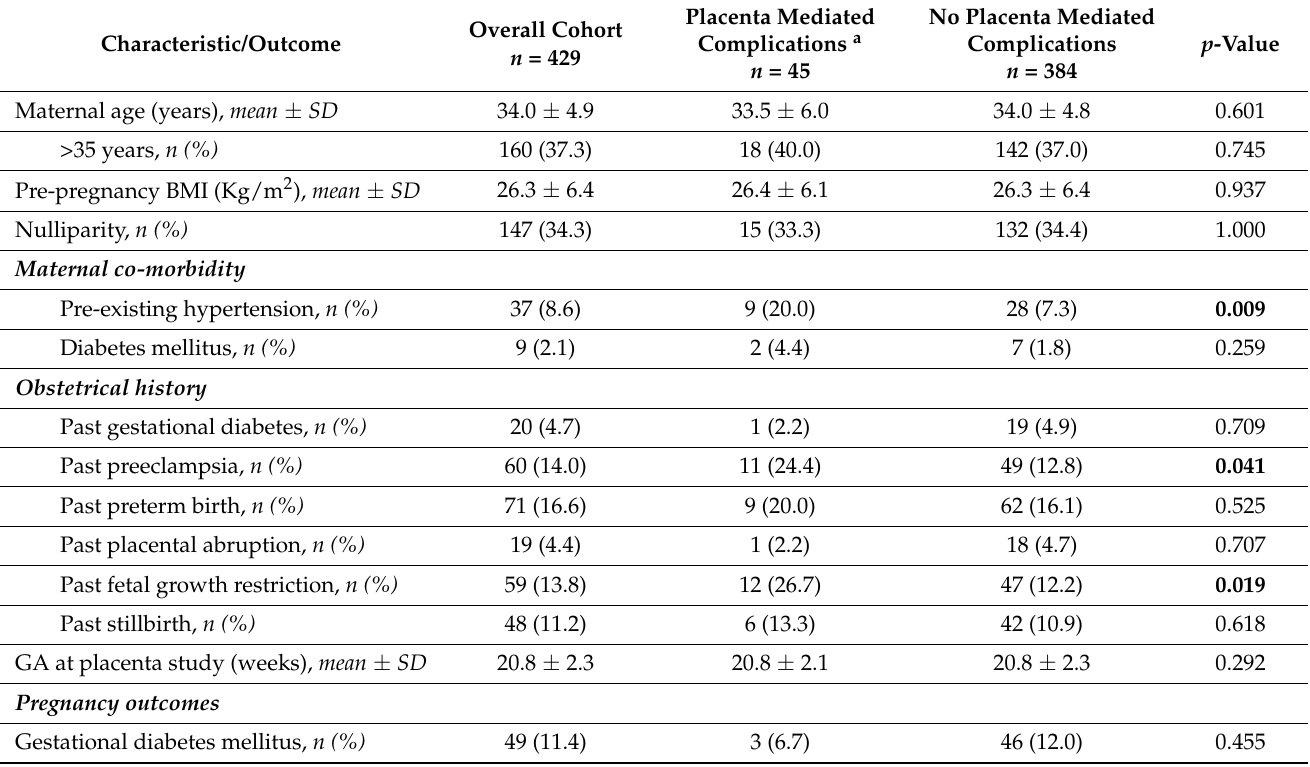
Table 1. Baseline characteristics and pregnancy